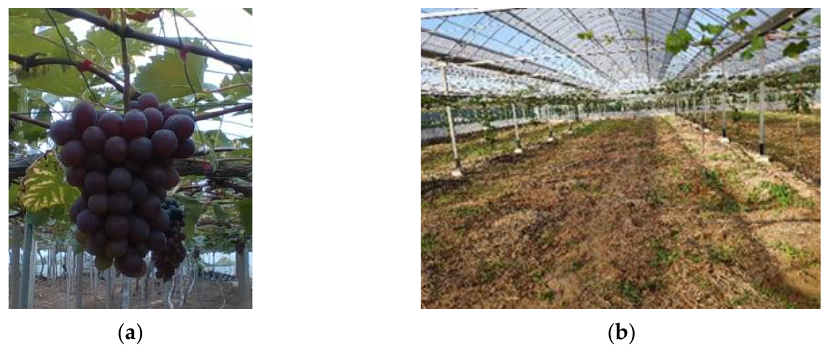
Figure 1. Trellis cultivation environment of grapes. ( a ) The front view of the overlapping grape clusters, and ( b ) the grape cultivation environment.